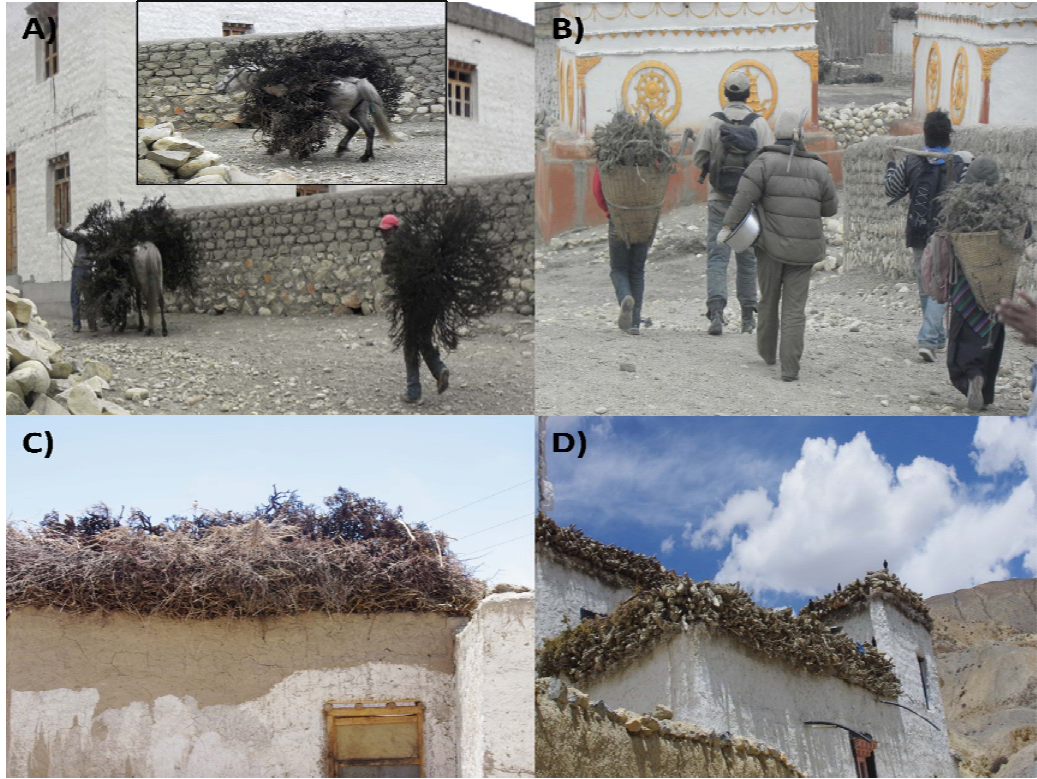
Figure 6. Transportation ( a , b ) and storage ( c , d ) of uprooted plants for winter